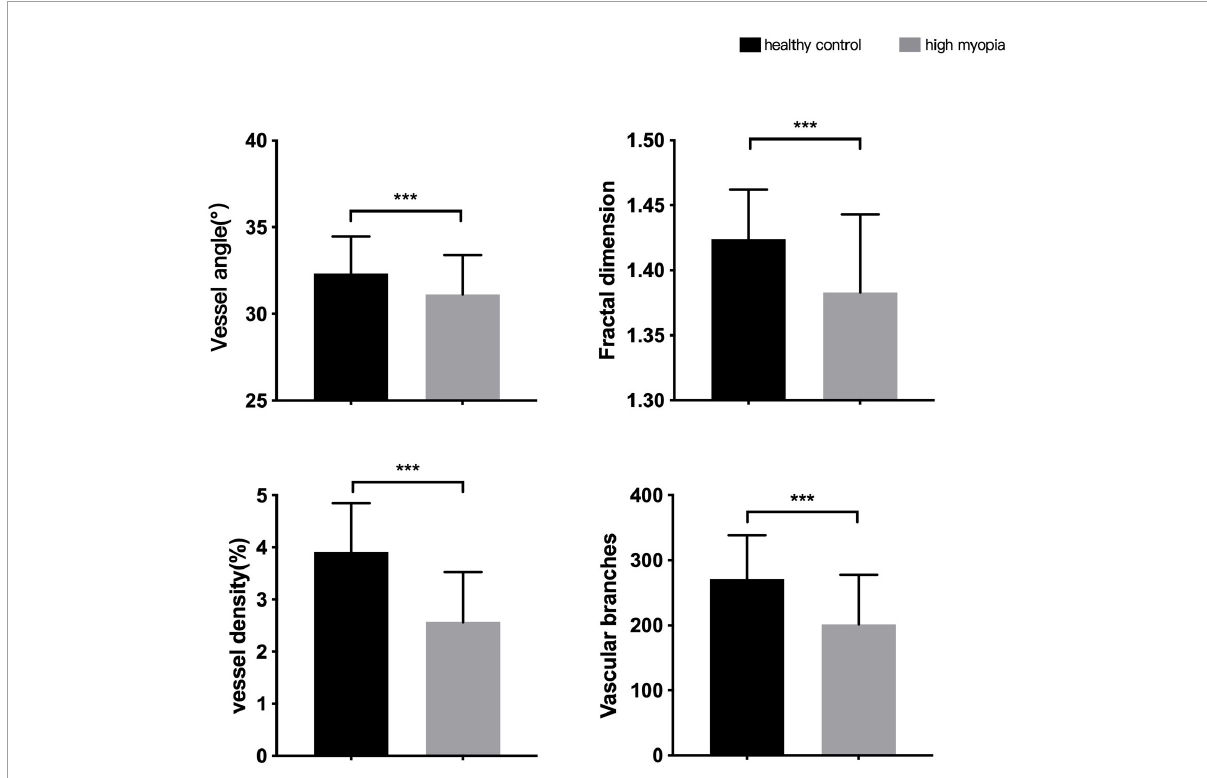
FIGURE3 Differences in morphological characteristics between HM group and healthy control group. *** P <